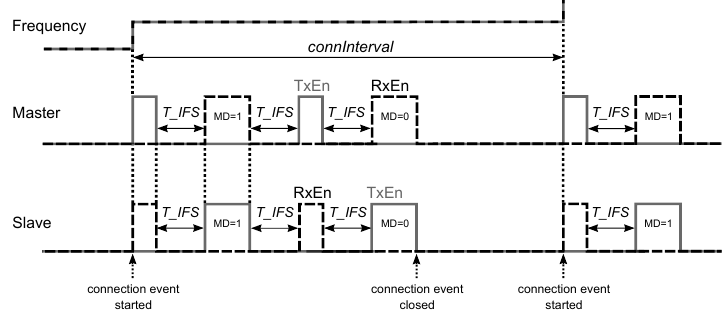
Figure 7. Continuation of the connection event by setting the MD bit to 1 in the packet sent by the slave.